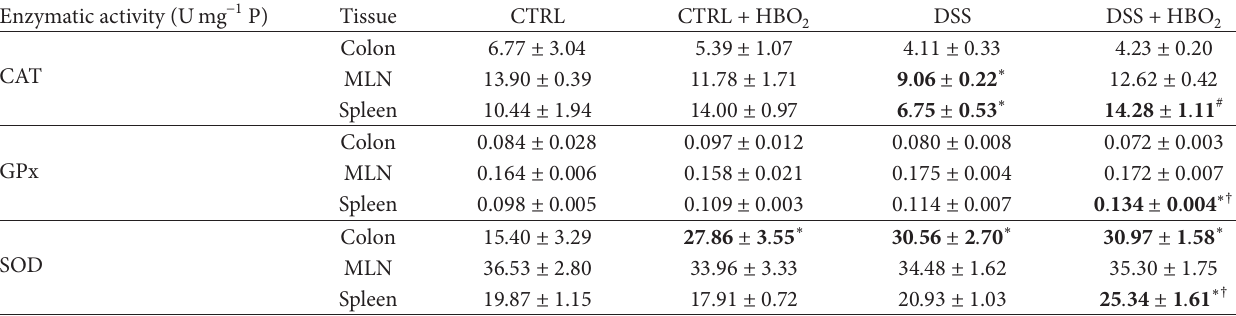
Table 2: Catalase (CAT), glutathione peroxidase (GPx), and superoxide dismutase (SOD) activity in the colon, MLN, and spleen during colitis and HBO 2